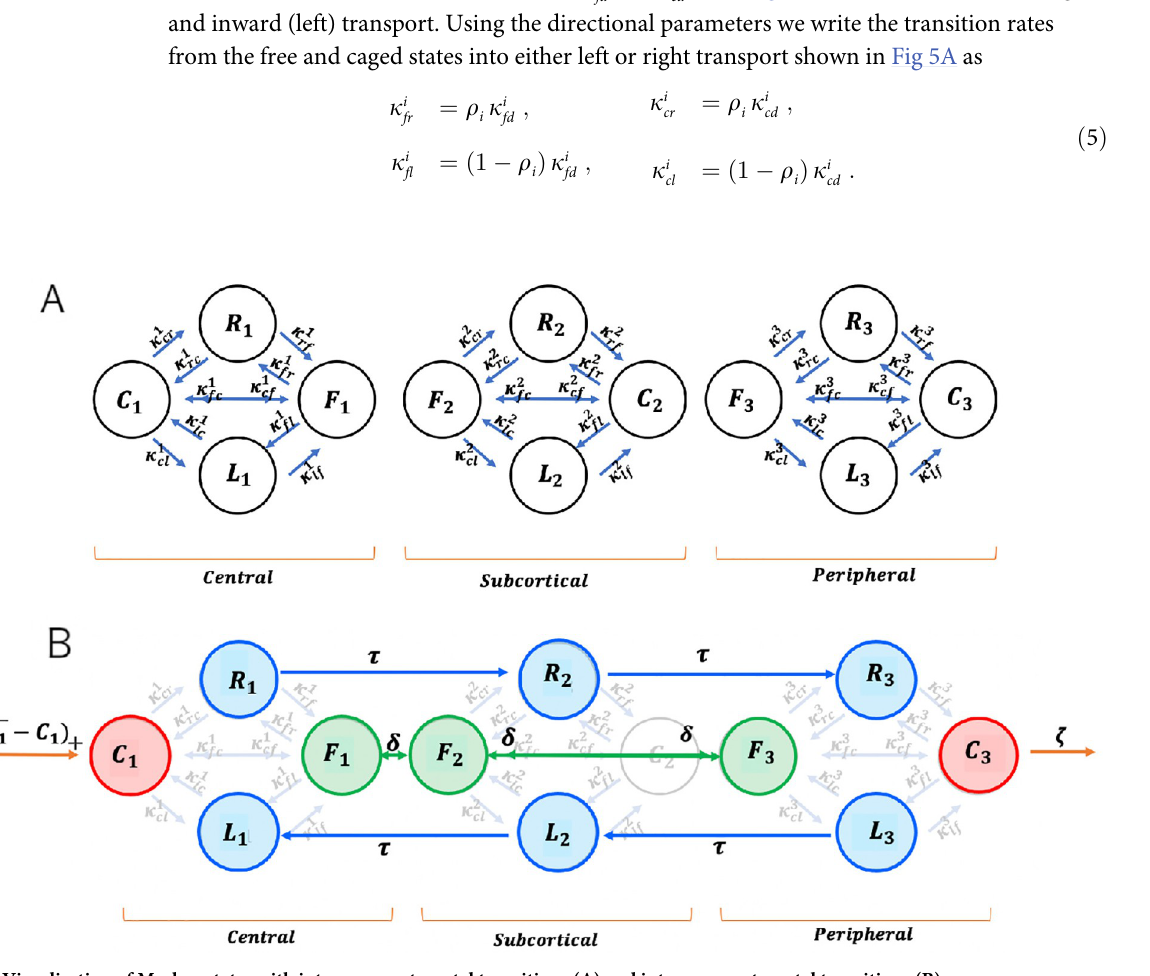
Fig 5. Visualisation of Markov states with intra-compartmental transitions (A) and inter-compartmental transitions (B).